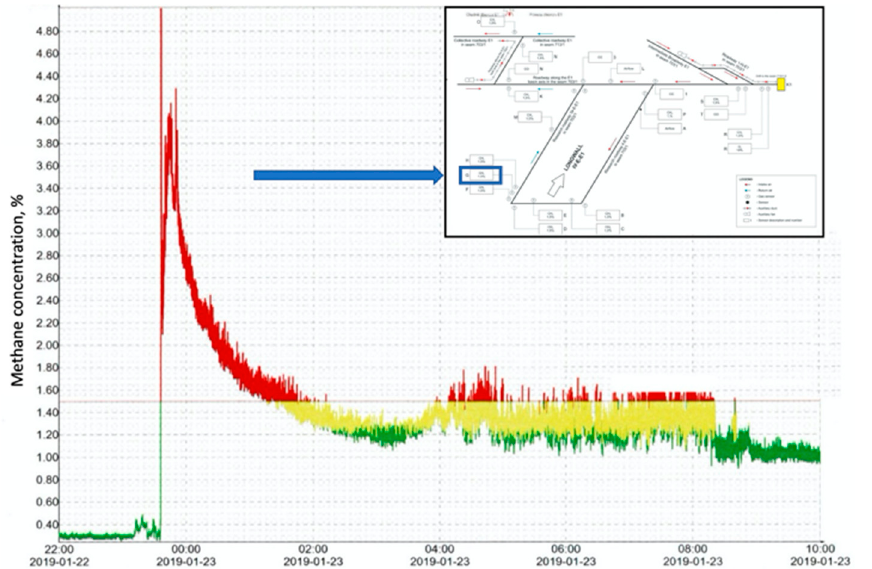
Figure 10. A change in methane concentration after the burst recorded by a CH 4 (G) sensor installed in the Researcher roadway 3a-E-E1 in seam 703/1 at the height of the longwall window (sensor G in Figure 4) [3].